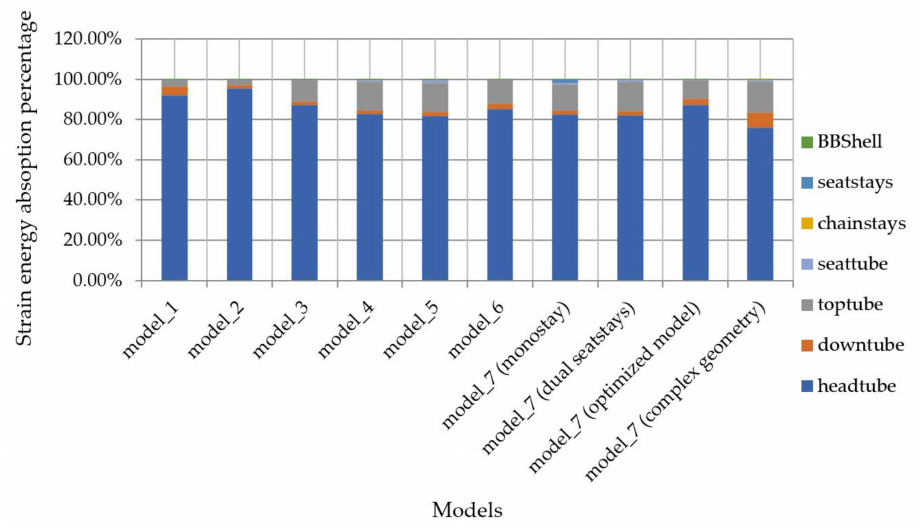
Figure 24. Absorption of strain energy and its distribution in a horizontal forces scenario.